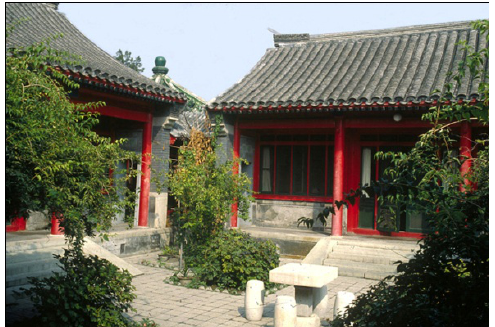
Figure 17. Siheyuan patio, showing vrandahs [8].